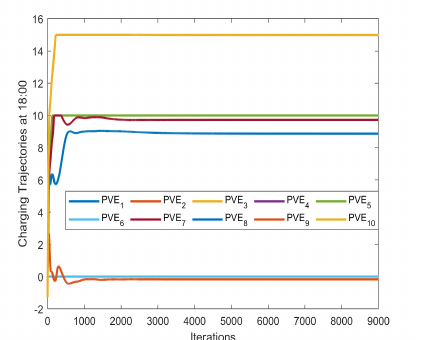
Figure 13. Charging trajectories of PEVs at 18:00.